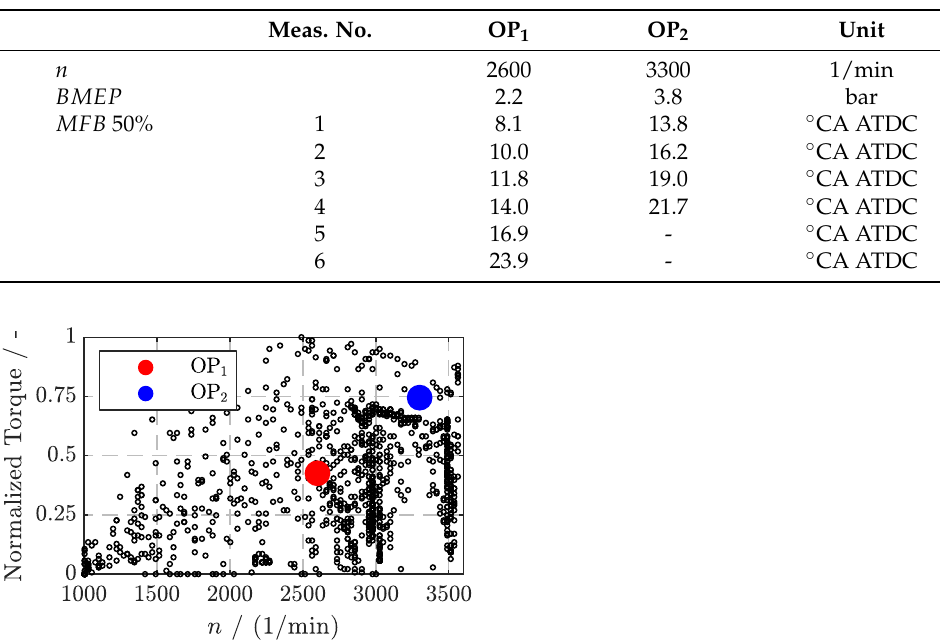
Table 3. Investigated operating points and values of MFB 50% variation.